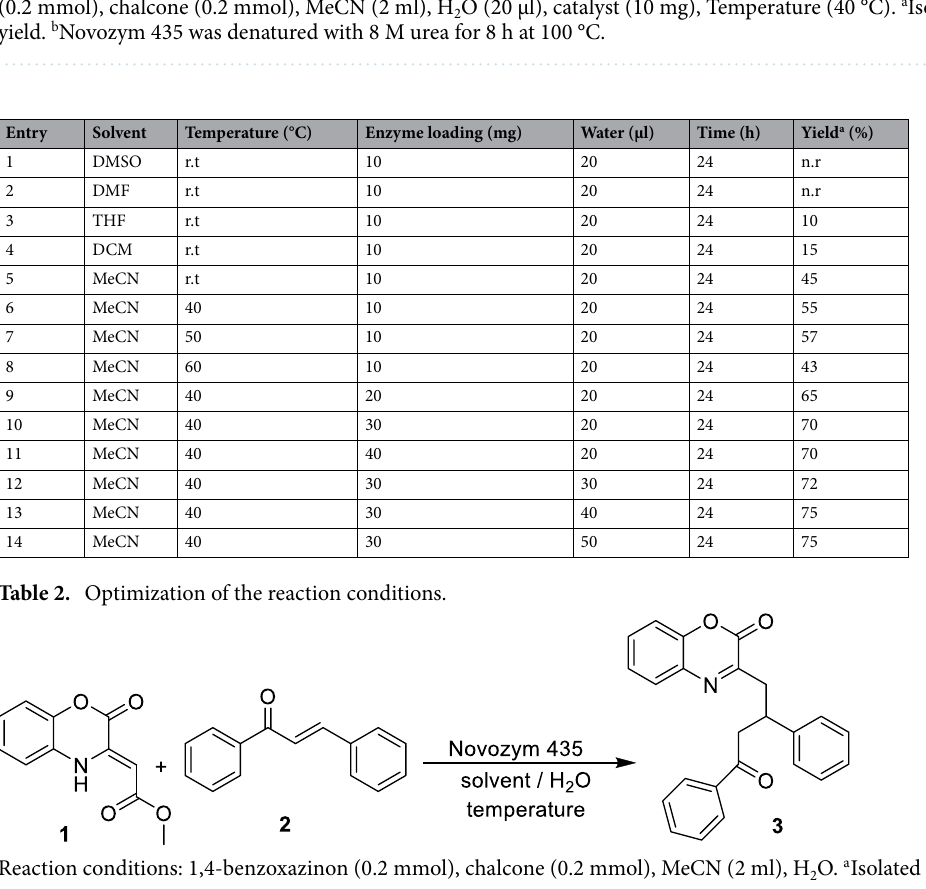
Table 1. Enzymatic screening for decarboxylative Michael reaction. Reaction conditions: 1,4 benzoxazinon (0.2 mmol), chalcone (0.2 mmol), MeCN (2 ml), H 2 O (20 µl), catalyst (10 mg), Temperature (40 °C). a Isolated